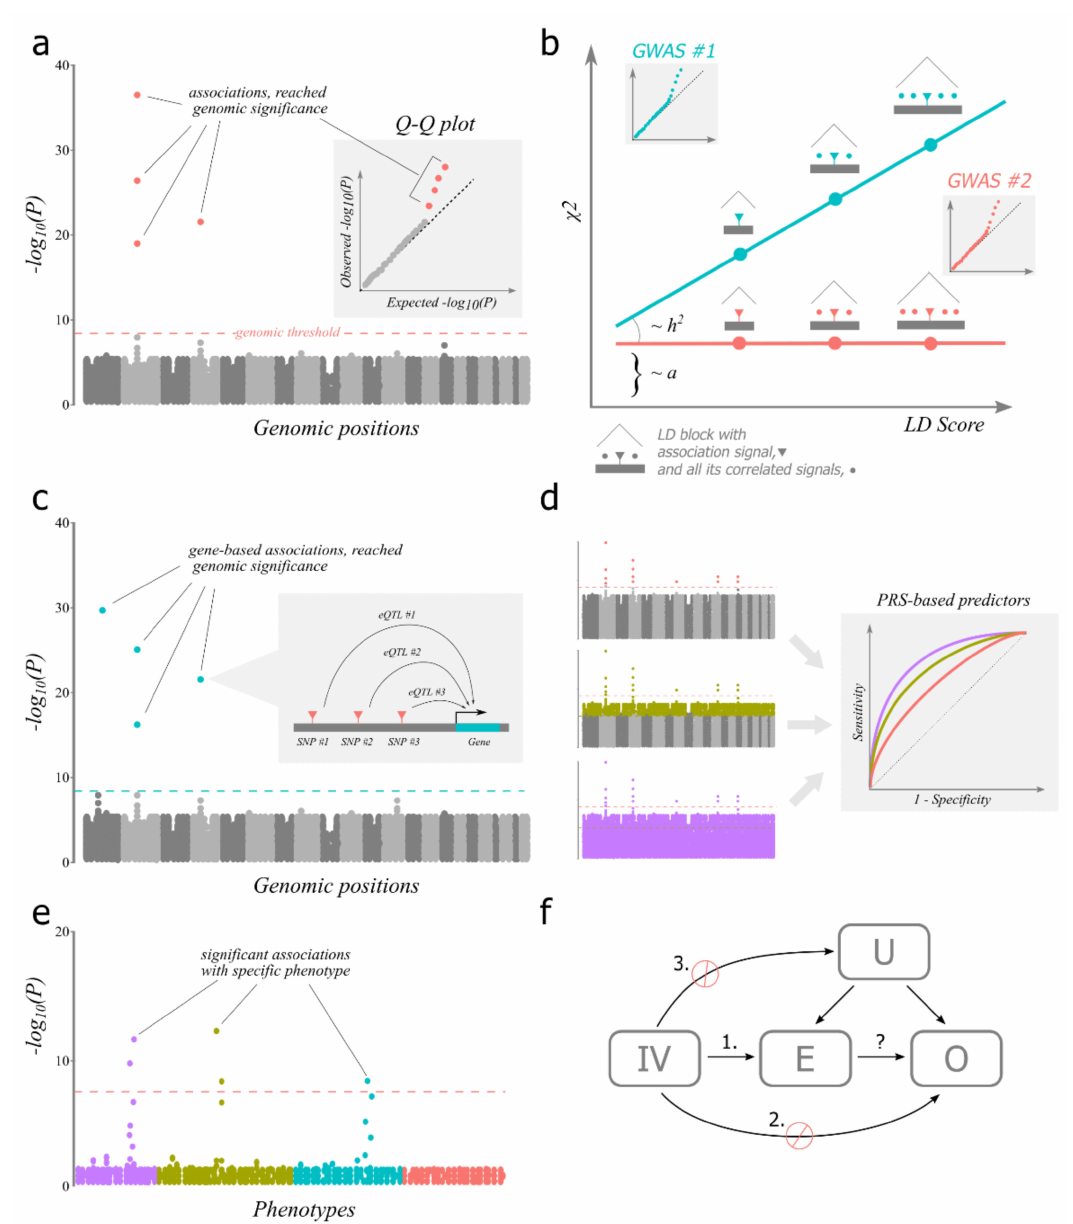
Figure 1. Main concepts discussed in the text. ( a ) GWAS . The scheme depicts the Manhattan plot, a main visualisation of GWAS results. Manhattan plot shows distribution of observed p -levels of individual association tests across genomic positions (represented as dots). Manhattan plot allows to quickly assess how many associations pass the genomic significance threshold (dashed line). Inset depicts the corresponding quantile-quantile (Q-Q) plot which shows the distribution of observed versus expected p -levels. ( b ) LDSC . The scheme shows differences in two GWAS experiments both with population bias and only one has true genetic effects (turquoise). The Q-Q plots for both experiments are depicted as insets to illustrate that they look the same. LD score is a sum of correlations between tested SNPs for a given SNP. Chi-squared is a measure of effect for a given SNP, modelled as a random variable. The slope of the regression is proportional to heritability ( h 2 ) and the intercept (a) is proportional to bias. ( c ) TWAS . The scheme depicts the Manhattan plot with gene-based associations.